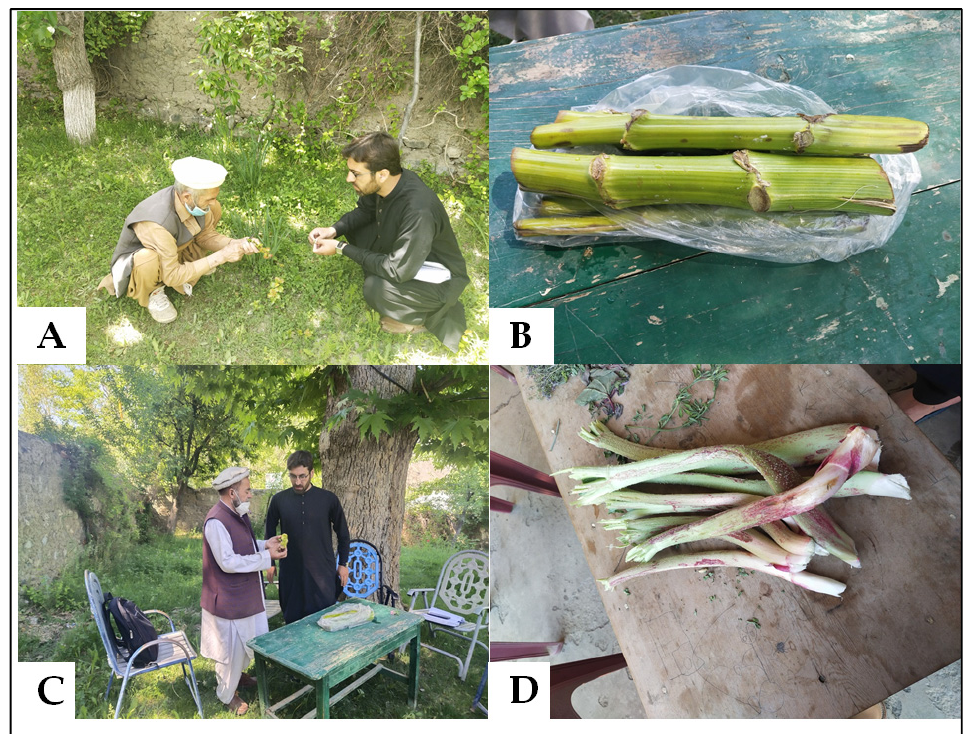
Figure 3. Plants found in some homes in the study area; ( A , C ) local informants explaining the uses of WFPs ( B ) Ferula hindukushensis and ( D ) Rheum ribes .